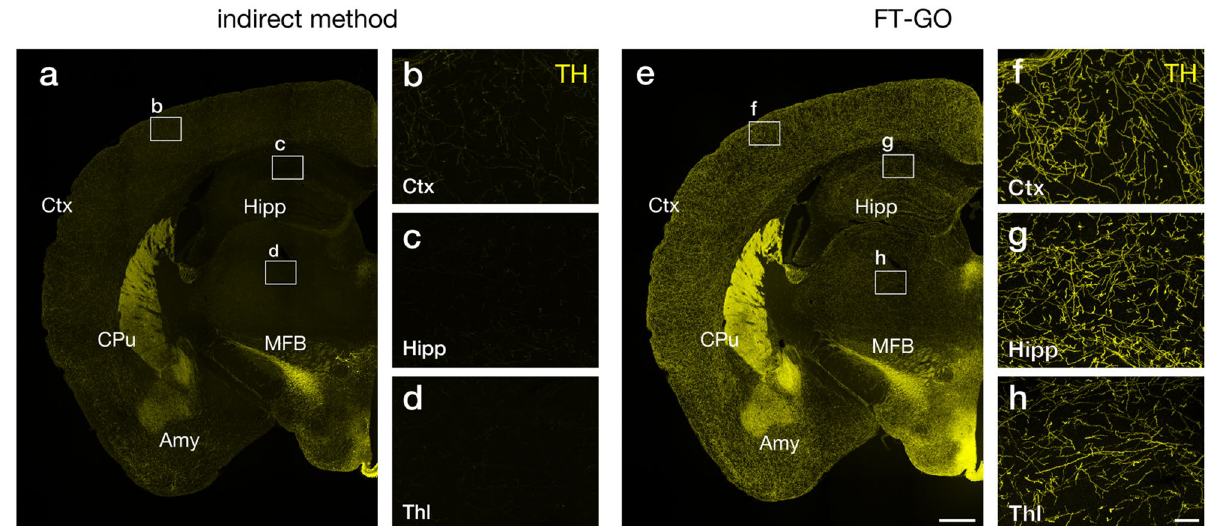
Figure 3. CA fiber innervation in the mouse brain visualized with FT-GO. (a–h) TH IF in mouse brain sections visualized with an indirect ( a–d ) and FT-GO method ( e–h ) (n = 3 animals for each condition). ( b–d,f–h) show higher magnification images in rectangles in ( a,e ). CF488A tyramide is used for color development in the FT-GO method. Amy amygdala, CPu caudate-putamen, Ctx cerebral cortex, Hipp hippocampus, MFB medial forebrain bundle, Thl thalamus. Scale bars: 500 µm in ( e ) and 50 µm in ( h ).